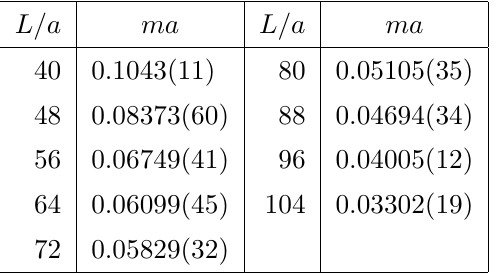
Table 1 . Results for the lightest mass contributing to the G ( τ, R ) correlator at t ≈ 0 , for different values of L = R